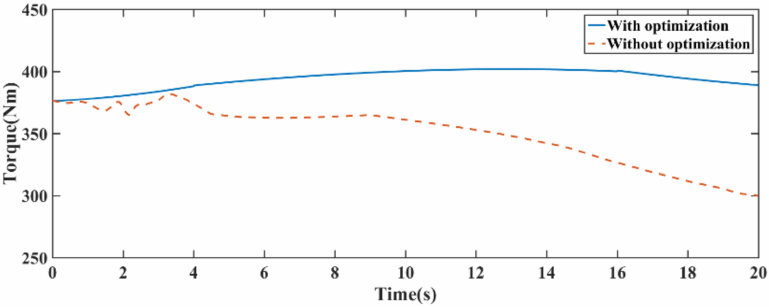
Figure 24. Torque exerted on the guardrail by the